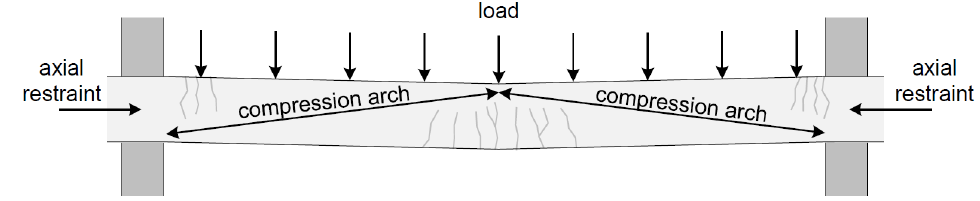
Figure 1. Basic principle of compressive membrane action.